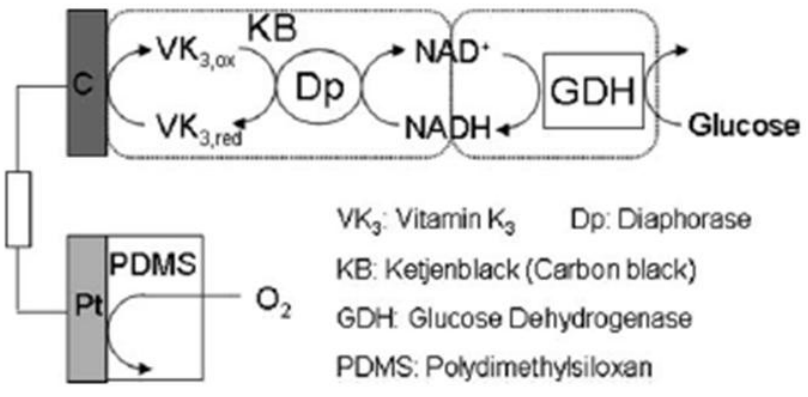
Figure 10. Reaction schemes in a biofuel cell based on GDH/Dp/VK cathode. Reprinted from [28] with permission from